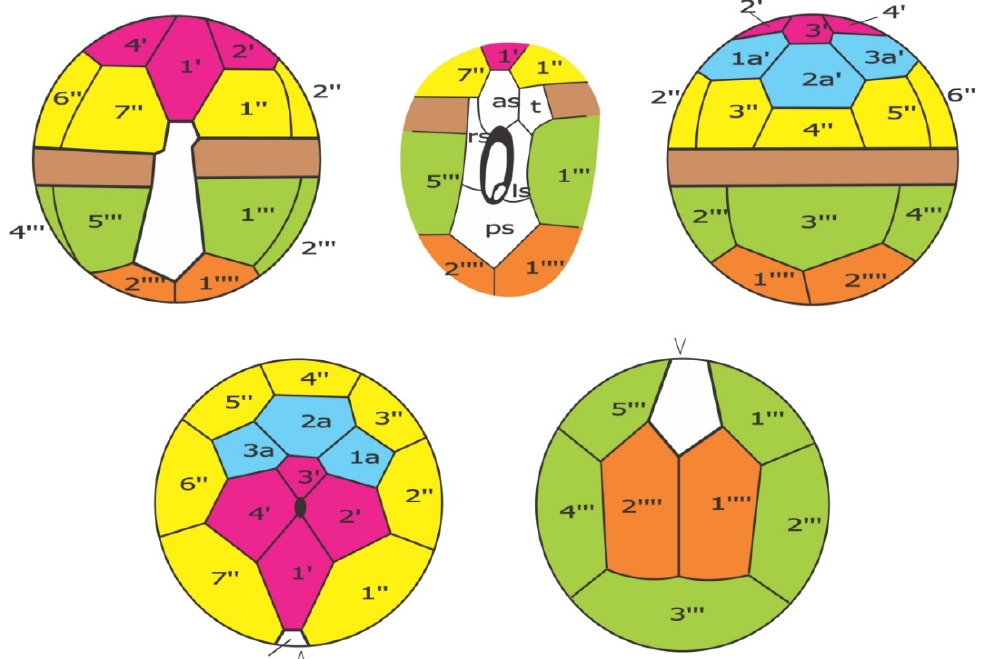
Figure 17. Standard peridinialean tabulation. Top left: ventral view. Top centre: detail of sulcus. Top right: dorsal view. Bottom left: apical view. Bottom right: antapical view. Note that there are: four apical plates (plates touching the apex and designated with a single “apostrophe”; shown in red); three anterior intercalary plates (plates between apical plates and precingular plates; shown in blue), seven precingular plates (plates anterior to and touching the cingulum and designated with two “apostrophes”; shown in yellow), five postcingular plates (plates posterior to and touching the cingulum and designated with three “apostrophes”; shown in green), and two antapical plates (plates at the antapex and designated with four “apostrophes”; shown in orange). Plates in the cingulum (brown) vary in number and are not indicted here. The tabulation formula for peridinioids can thus be formulated as 4 ′ , 3a, 7 ′′ , xc, 5 ′′′ , 0p, 2 ′′′′ . At top centre, showing details of the sulcus, as = anterior sulcal plate, t = transitional plate, rs = right sulcal plate, ls = left sulcal plate, and ps = posterior sulcal plate. At bottom left, as = anterior sulcal plate and the inverted v indicates flagellar insertion. Adapted from Fensome et al. [43].